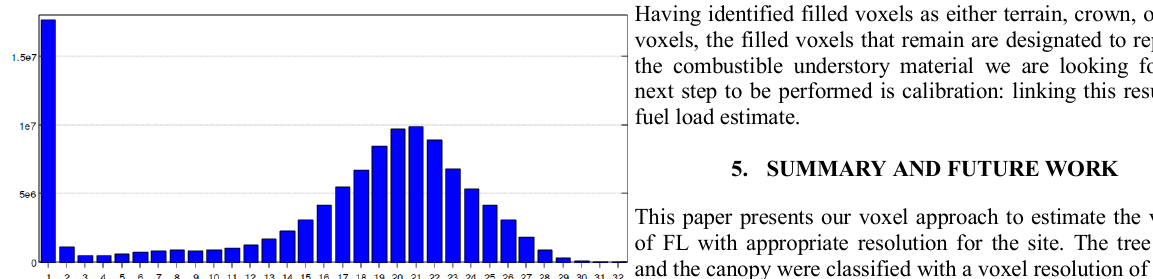
Figure 15: Voxelised tree trunk of the study